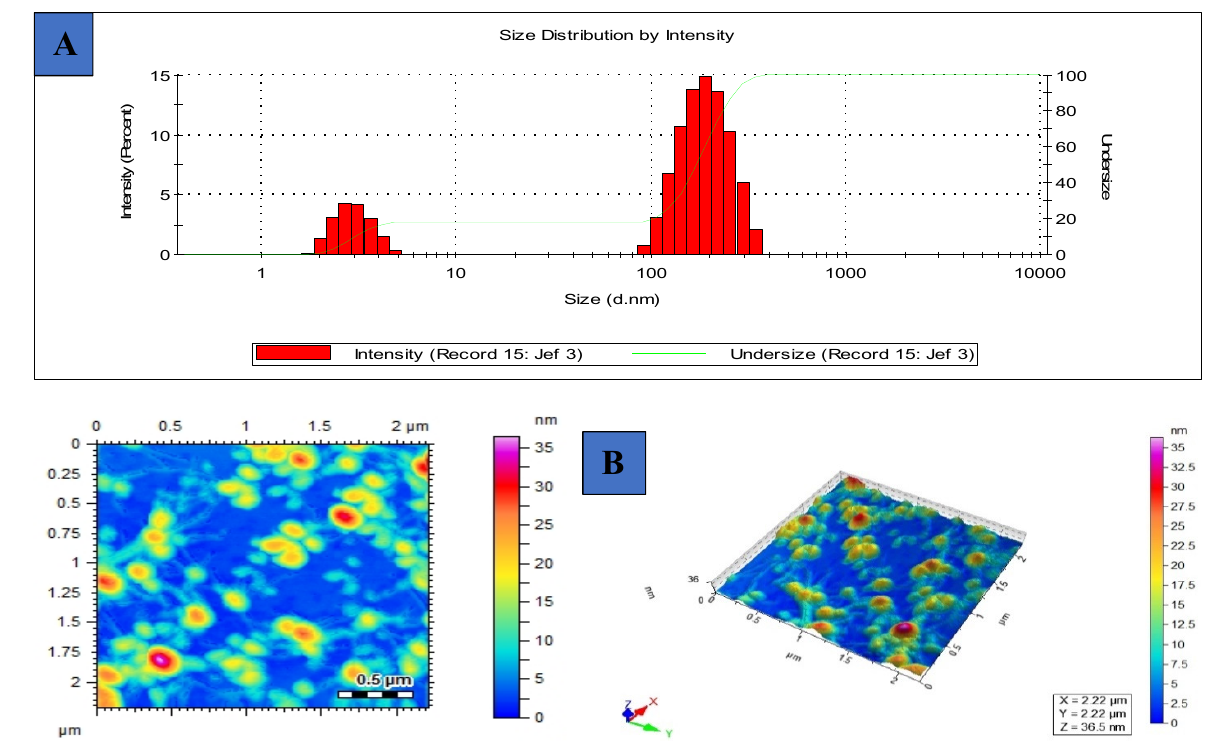
Figure 5. DLS intensity profile: ( A ) average size of Jeff-[G10a] 2 -SHa using Zetasizer, ( B ) atomic force microscopic image of Jeff-[G10a] 2 -SHa.